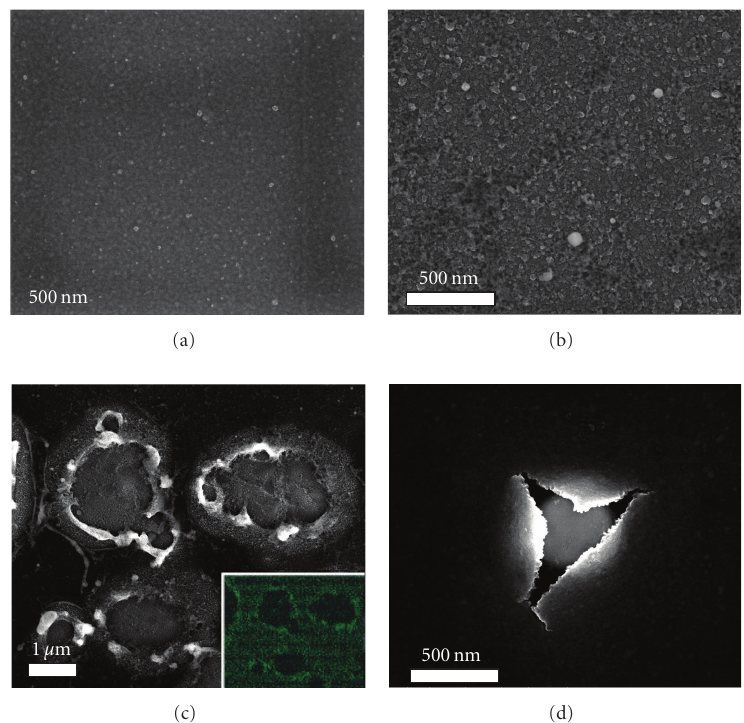
Figure 7: SEM images of (a) polymer layer and (b) the top aluminum electrode show no damage when cycles of 8 V were applied to the Al/PVA (10nm)-PMMA (22nm)/Al device. Contrary to the first case, when cycles of 20 V were applied, SEM images show physical damages in both, (c) the PMMA layer and the (d) top aluminum electrode. The inset of (c) shows the aluminum elemental mapping of the PMMA